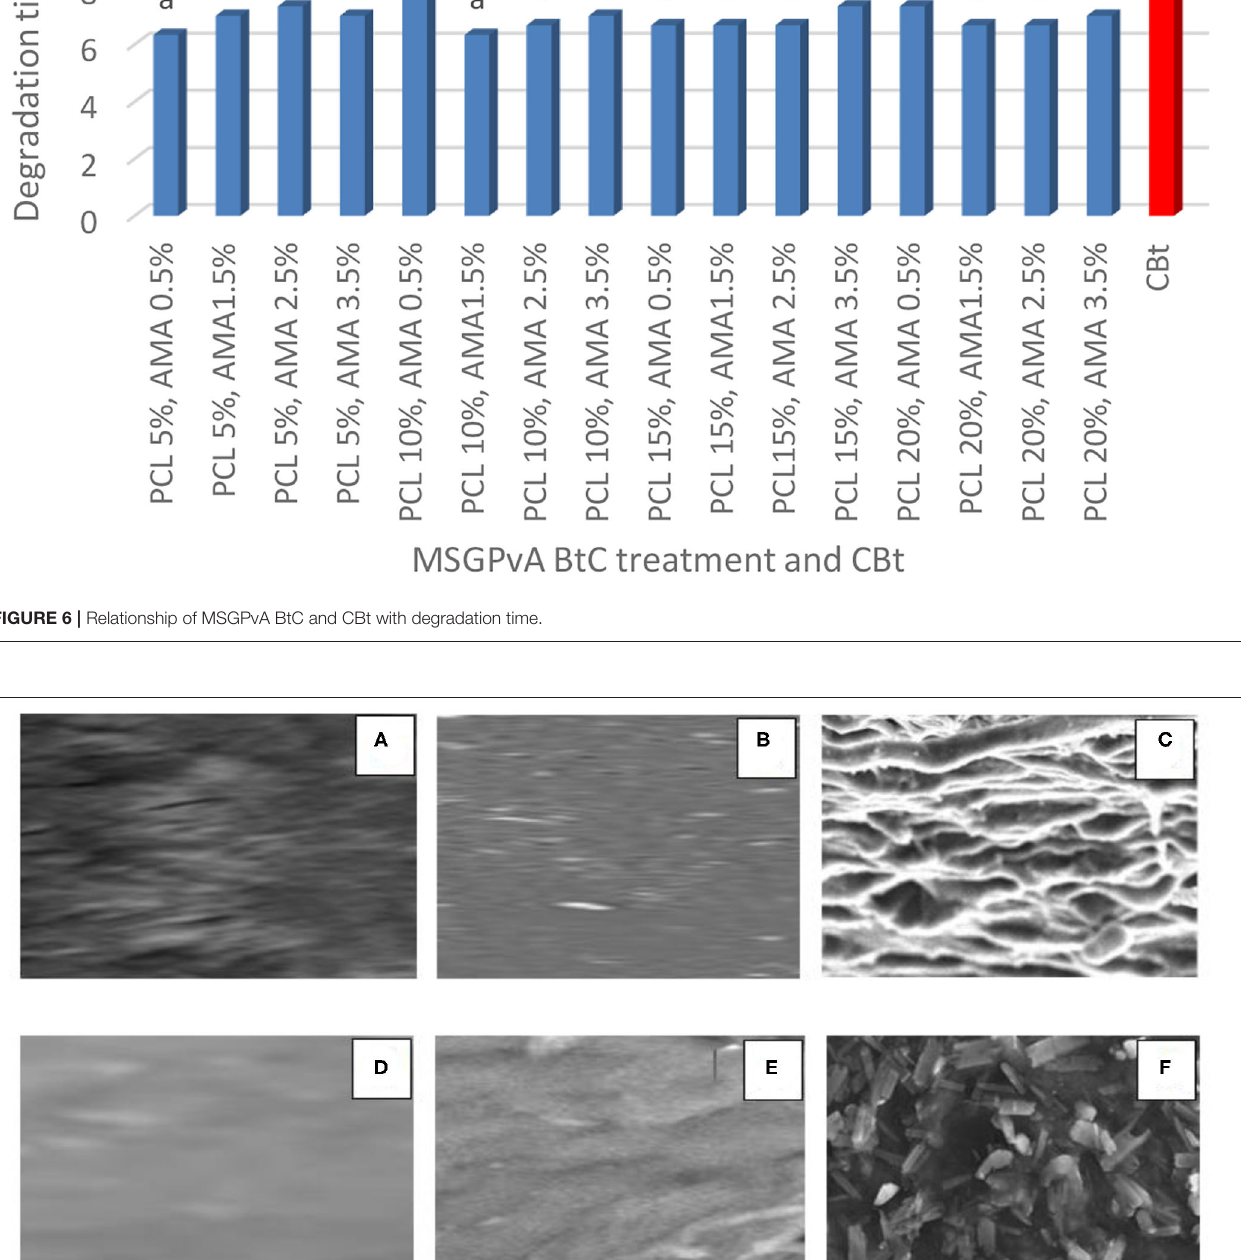
Frontiers in Sustainable Food Systems |